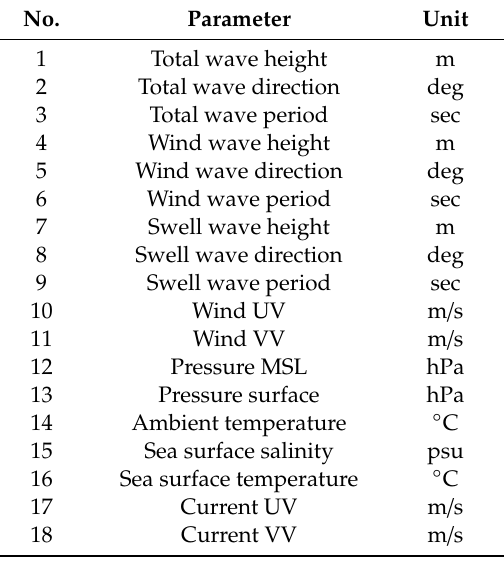
Table 4. Marine weather data